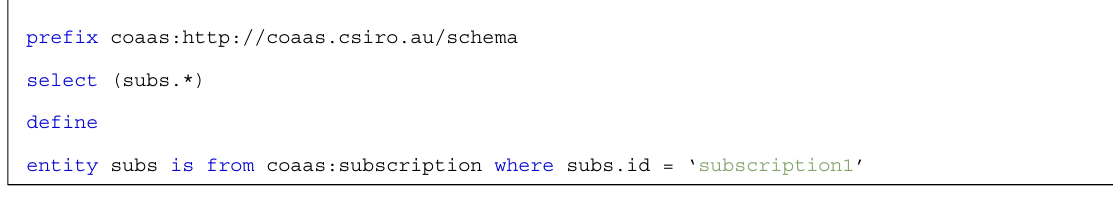
Scheme 8. Example of querying the results of subscriptions.